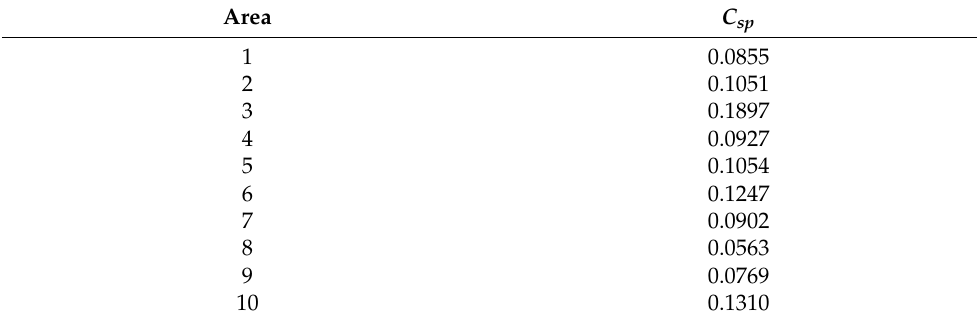
Table 6. The complexity on ship position for the ten studied water areas.